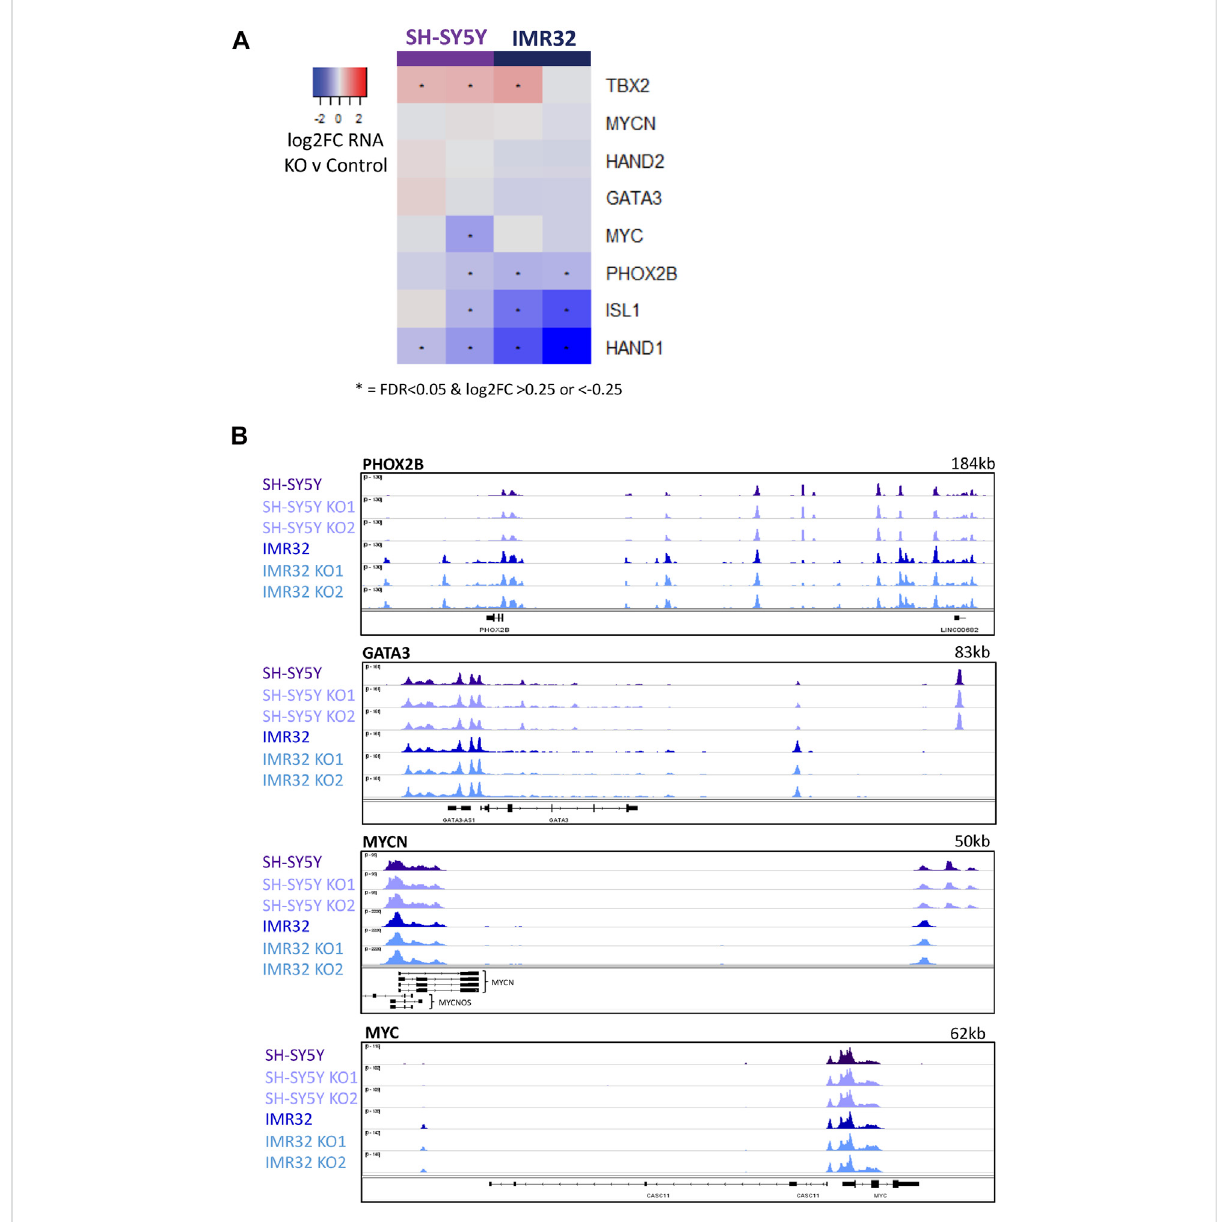
FIGURE 5 ASCL1KOdoesnothaveaneffectonCRCtranscription. (A) HeatmaphighlightingthechangeinRNAexpressionofkeyCRCgenesinASCL1KO linescomparedtoparental,*indicatessigni fi cantgeneswithap.adj < 0.05andalog2FC > 0.25/ < -0.25. (B) ATAC-Seqtracksshowingregionsaround the key TFs PHOX2B, GATA3, MYCN and MYC. ATAC-Seq was completed on 4 biological